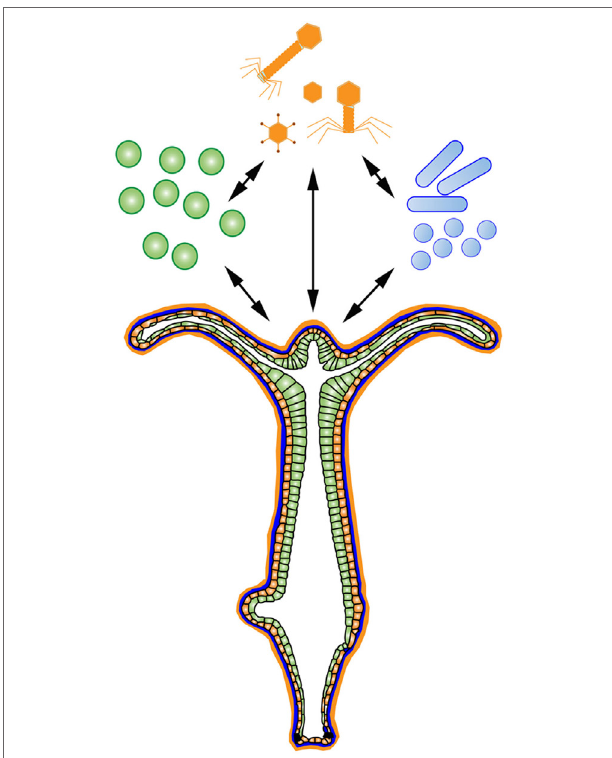
FiGUre 2 | The Hydra Holobiont. Hydra are an ideal system to deconstruct and reconstruct an organismal holobiont consisting of associated eukaryotes (green), prokaryotes (blue), and viruses (orange) at an exposed